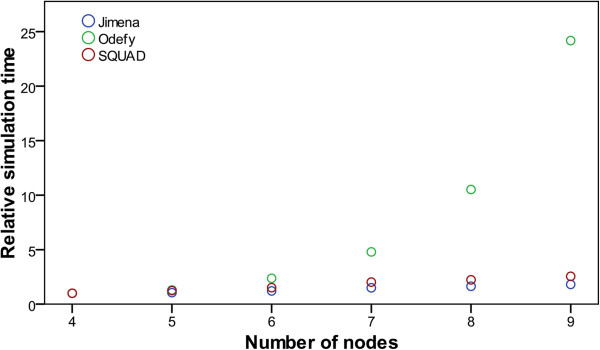
Simulation time for a continuous model. x-axis: number of involved nodes. y-axis: Time (in seconds) to simulate a standardized network with the given number of nodes. Note that in all figures the number of nodes refers to the number of actual network nodes xi as opposed to the number of nodes in the Boolean tree. To highlight the time complexity of the different calculation methods, the data series are scaled to coincide for a network with 4 nodes. Actual simulation times for 4 nodes: Jimena (red) = 0.019 s, Odefy (blue) = 0.040 s, Squad (green) = 0.046 s. The Additional file 1 explains the definition of the network for a given number of nodes.